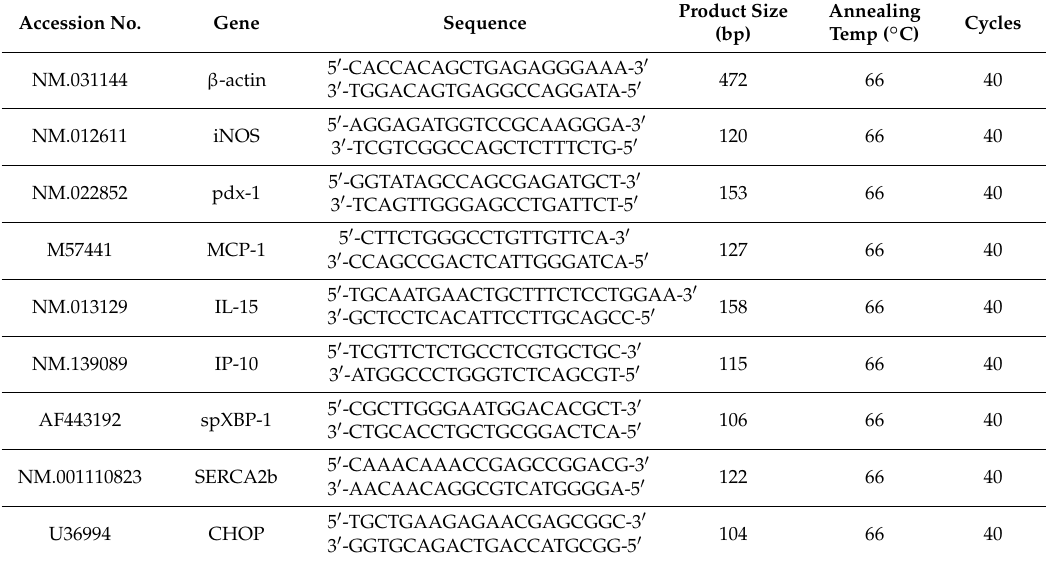
Table 1. Primers used to analyze mRNA expression by real-time